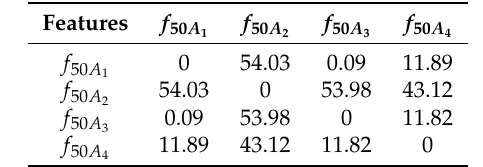
Table 6. Euclidean Distance Matrix Calculated for Selected Features (Table 2) for 50 Hz Audio ENF Signals.